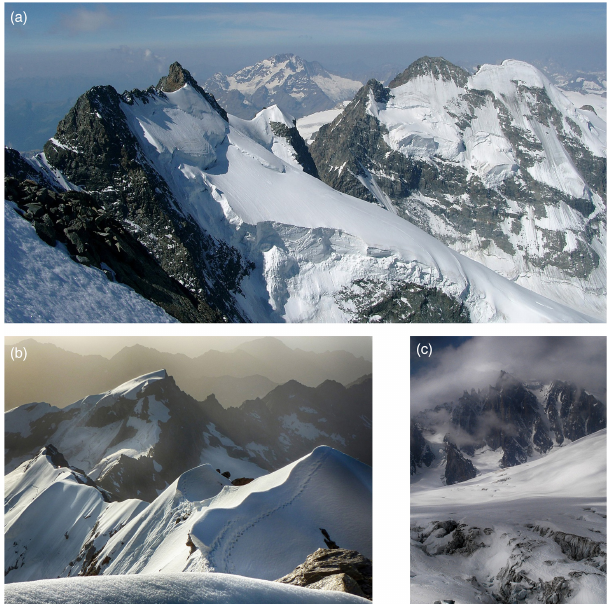
Figure 10. Mountain landscapes. (a) Piz Bernina (Italy). The PNRA–WISSLAKE project, including (b) Monte Rosa (Italy) and the (c) Géant Glacier of Mont Blanc (Italy).